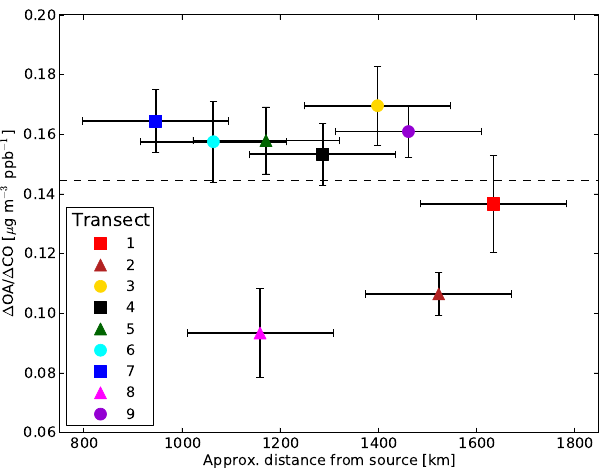
Figure 8. Transect (cid:49) OA /(cid:49) CO enhancement ratios for Flight b622 as a function of the distance from the source fire region. The average ER is represented by the dashed black line (0.144µgm − 3 ppb − 1 ) . There is no discernible trend in (cid:49) OA enhancement either by dis- tance ( x axis) or time (colours). The uncertainty bars display the uncertainty in distance and in fitted enhancement ratios.